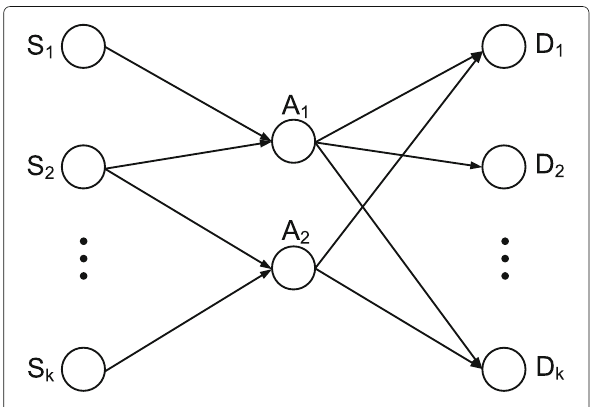
Fig. 10 Illustration of a K × 2 × K